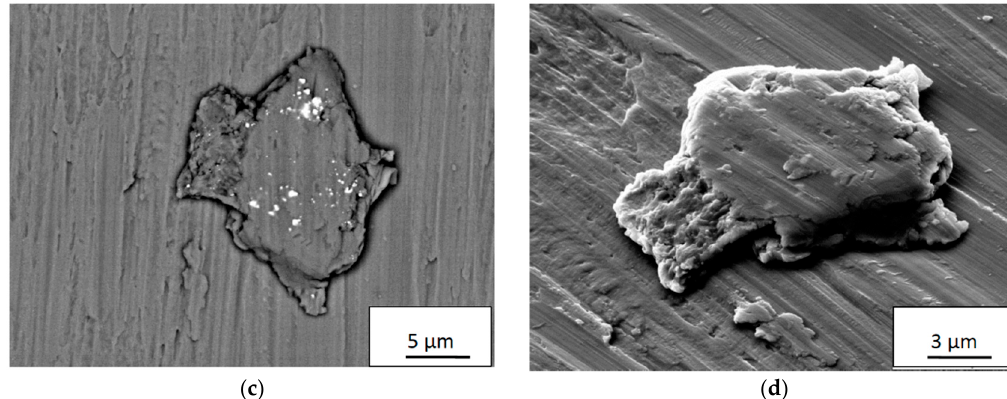
Figure 23. ( a ) Fragments (indicated by arrows) of Ti6Al4V build-up layers containing fine debris of the diffusion WC 1 − x layer found on the back-side of Ti6Al4V chips. ( b ) and ( c )High magnification SEM BEI micrographs showing the presence of WC 1 − x debris in the surface of the detached build-up layer fragments. ( d ) SEM tilted-view micrograph of the build-up layer fragment in Figure c .